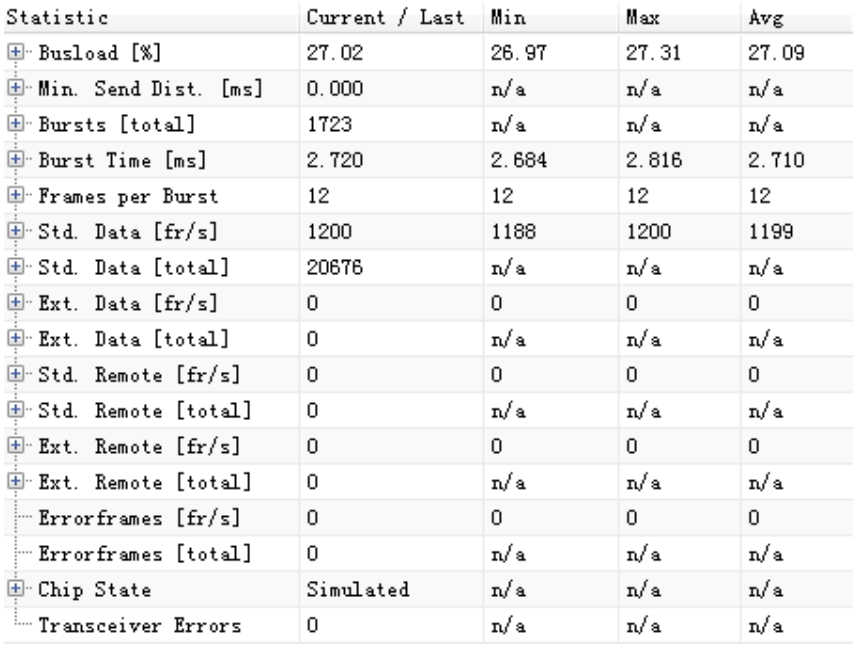
Figure 22. The CAN communication evaluation parameters in